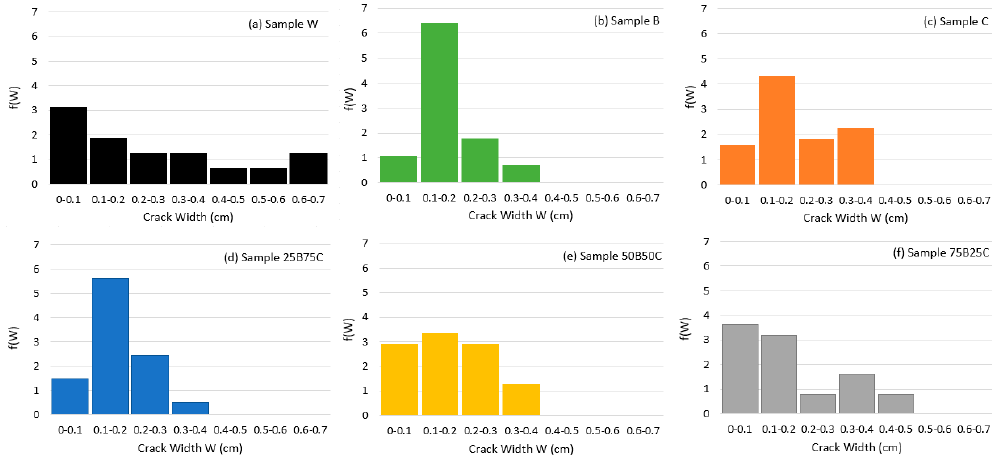
Figure 8. Probability distribution of crack width of four soil samples after 48 h of drying. 398